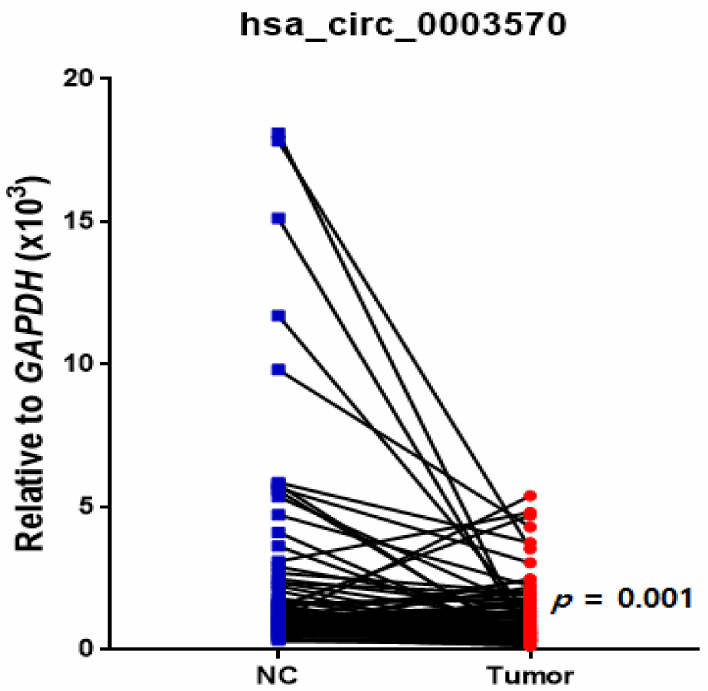
Figure 1. Dot plot of hsa_circ_0003570 expression in noncancerous (NC) tissue and cancer tissue in hepatocellular carcinoma. A paired t -test showed that hsa_circ_0003570 expression decreased in tumor tissue compared to that in the NC tissue ( p =